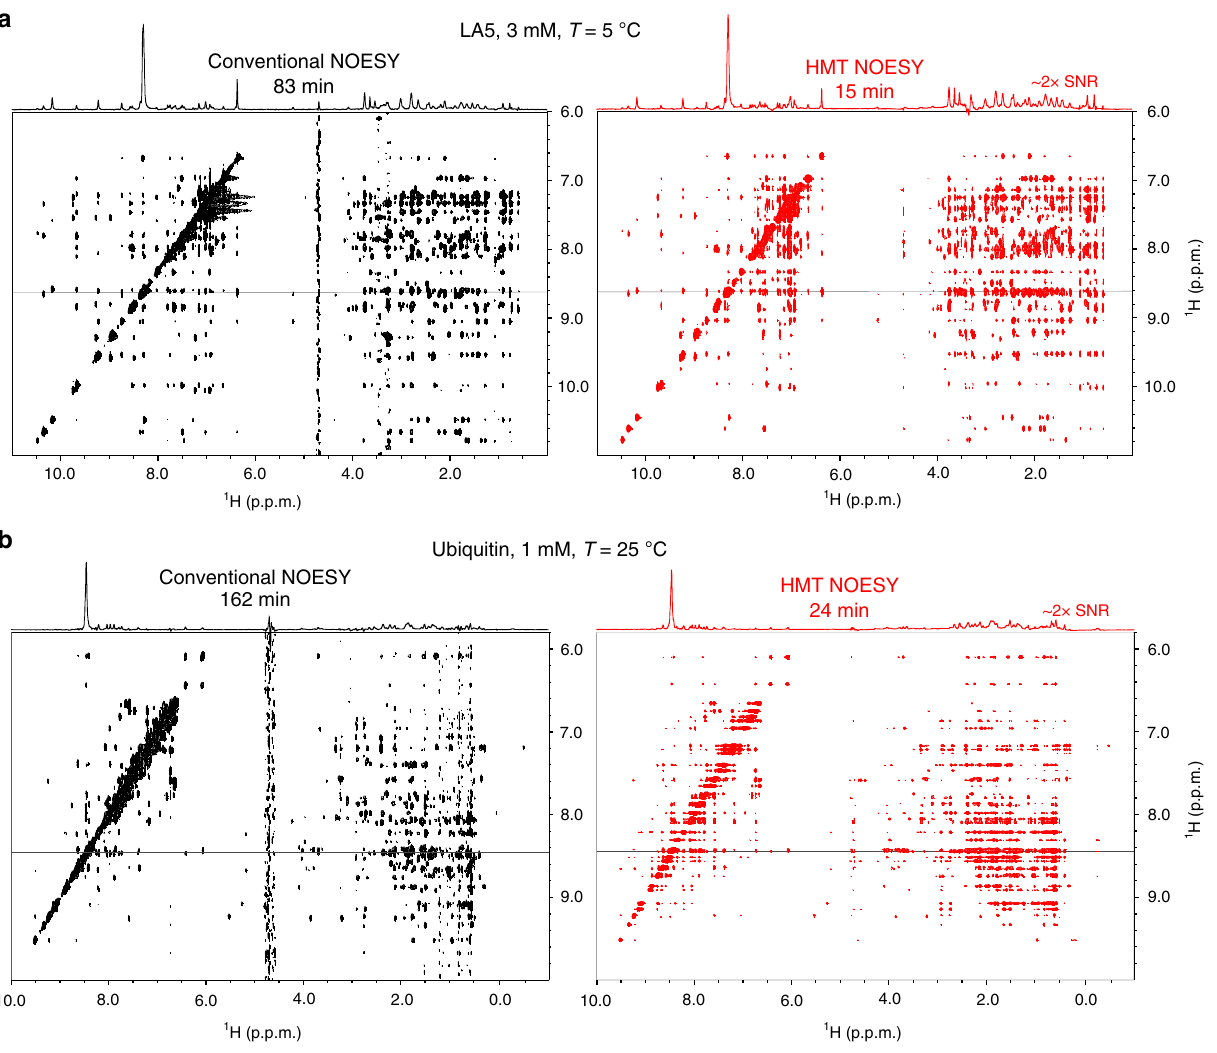
Fig. 4 HMT applied to enhance correlations in folded proteins. Conventional vs HMT NOESY spectra recorded for LA5 a and ubiquitin b samples. Notice how the 23.5 T fi eld is suf fi cient to resolve almost entirely the amide/amino resonances in these structured peptides (regions between 6.6 – 9.5 ppm) and enable fast, highly sensitive NOESY experiments by Hadamard MT. Conventional experiments were acquired with 300 ms and 250ms mixing, respectively (for maximum NOESY cross-peaks); HMT employed 6 × 150 ms and 6 × 140 ms looped encoding. Spectra were acquired at 1 GHz using a Bruker Avance Neo console equipped with a TCI